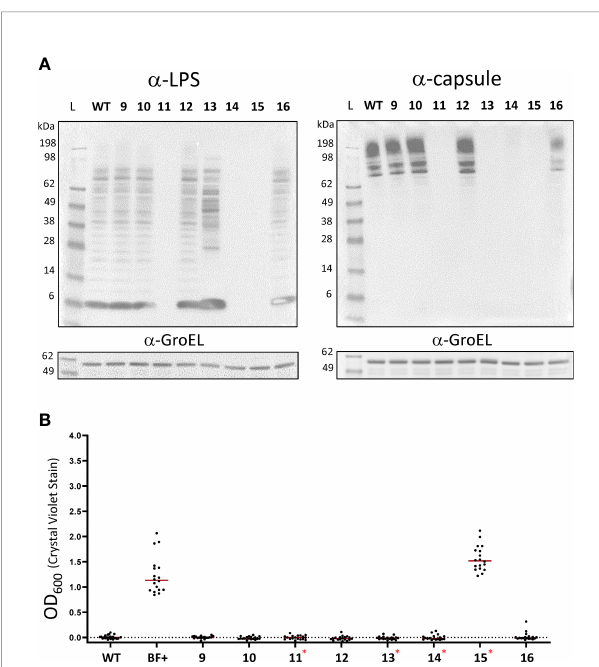
FIGURE 8 | Grey variants are responsible for the production of bio fi lm in F. tularensis . (A) Bio fi lm formation of puri fi ed constitutive bio fi lm forming isolates assayed by crystal violet staining after 3 days of growth in CDM. Grey shaded area highlights fully virulent Type A and B F. tularensis isolates and the isogenic bio fi lm former. (B) Western blot analysis was performed on the puri fi ed bio fi lm forming isolates to assess LPS and capsule. Bacteria were suspended to an equal OD 600 . Cell pellets were lysed and were separated on SDS-PAGE gels blotted with either a -LPS (left) or a -capsule (right). Equal amounts of whole cell extracts were loaded, with the exception of 244 and 255 as these isolates were diluted 1:4 and 1:2, respectively. In each case, a -GroEL was used as a loading